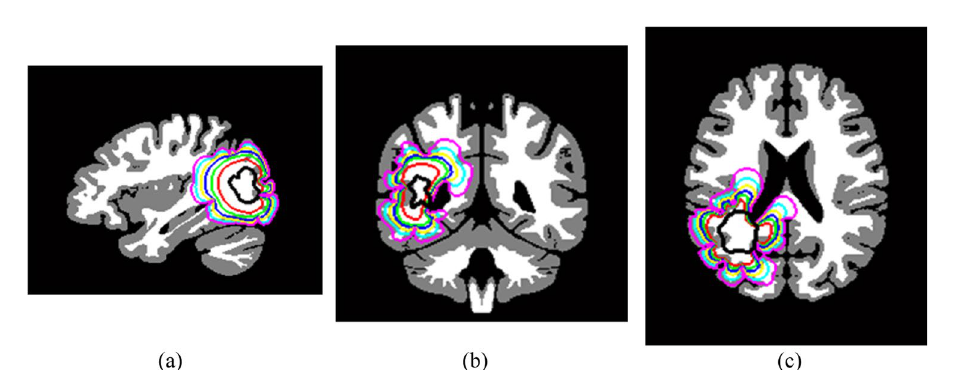
Figure 3. Simulation of the synthetic growth of tumor from single point on MNI atlas. The red, blue, and cyan contours represent the tumor boundaries for 1, 1.5, and 2 years, respectively, with treatment effect; while the green, yellow, and magenta contours represent the tumor boundaries for 1, 1.5, and 2 years, respectively, without treatment effect. ( a ) Sagittal slice, ( b ) coronal slice, and ( c ) axial slice.